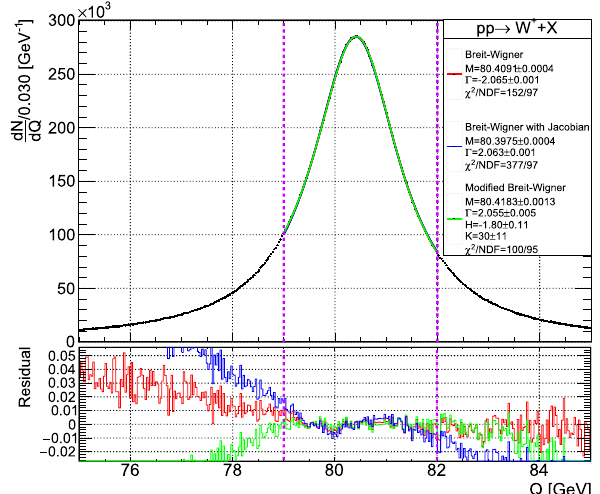
Fig. 3 The dilepton mass distribution for the inclusive W + sample. The result of the fit using the Breit–Wigner (red), Breit–Wigner with Jacobian (blue), and modified Breit–Wigner (green) are superimposed to the distributions. In the bottom pad, the residuals between the fit- ted function and the histogram are shown. Only events in the range [ 79 , 82 ] GeV (marked by the vertical dashed lines) are used in the fit. A similar result is obtained for the W −